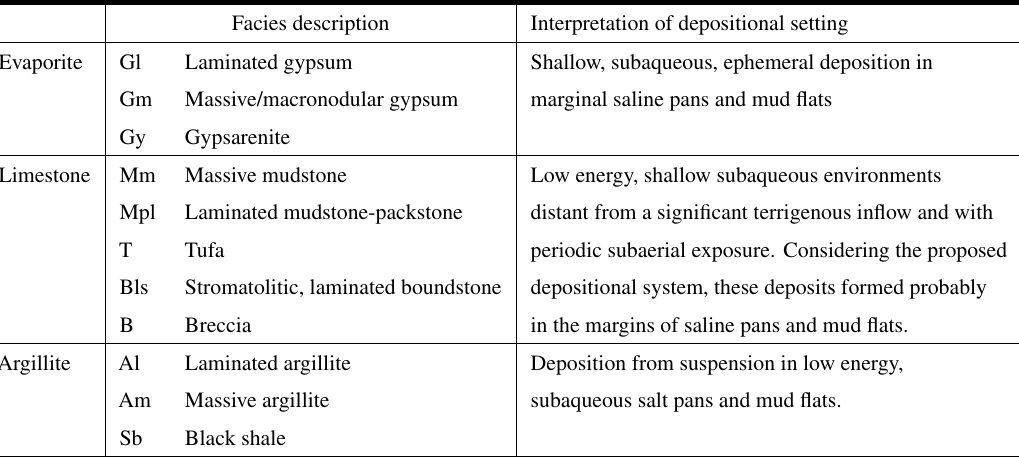
Synthesis of facies characteristics of the Codó Formation in the Grajaú